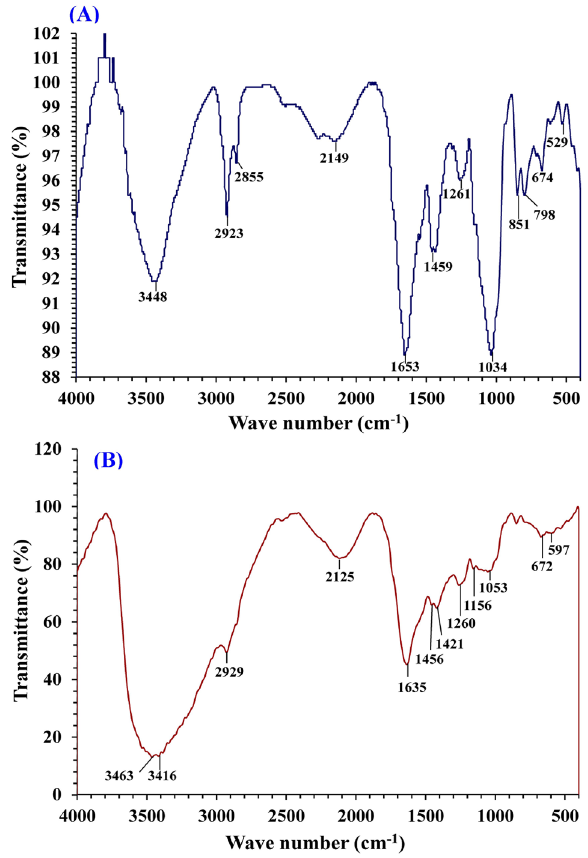
Figure 6. FTIR analysis of Enteromorpha intestinalis biomass: ( A ) before and ( B ) after simultaneous biosorption of cobalt and Congo red dye.